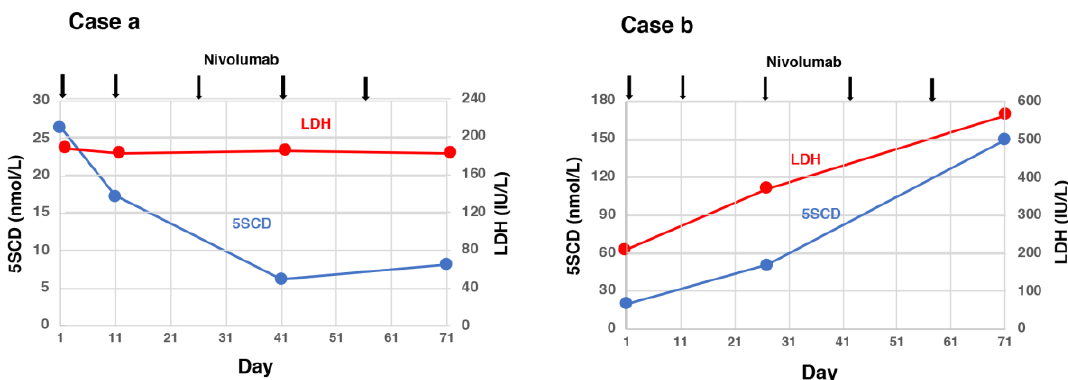
Figure 2. Serum 5SCD and lactate dehydrogenase (LDH) levels at baseline and treatment with nivolumab (Nivo). Case a—Serum 5SCD at 41 days after the first administration of Nivo was decreased, while serum LDH remained stable. The result of Nivo was determined as a partial response. Case b—Serum 5SCD and LDH at 27 days after the first administration of Nivo were highly increased. The result of Nivo was determined as progressive disease. This Figure was modified with the consent of authors (Omodaka et al, [100]).